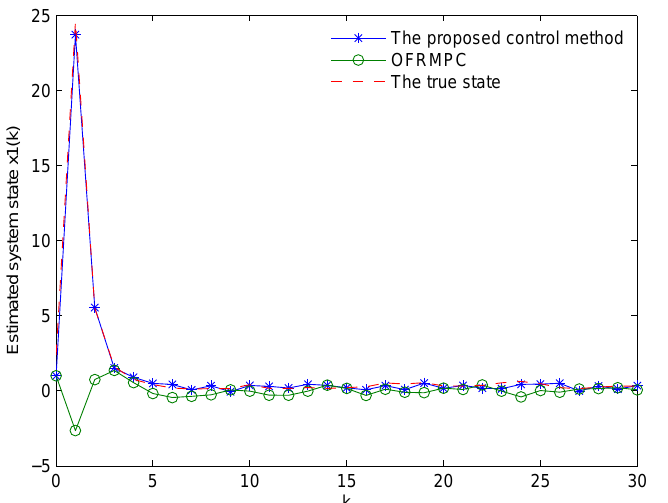
Figure 1. The system state x1 and estimated state for the proposed method and OFRMPC